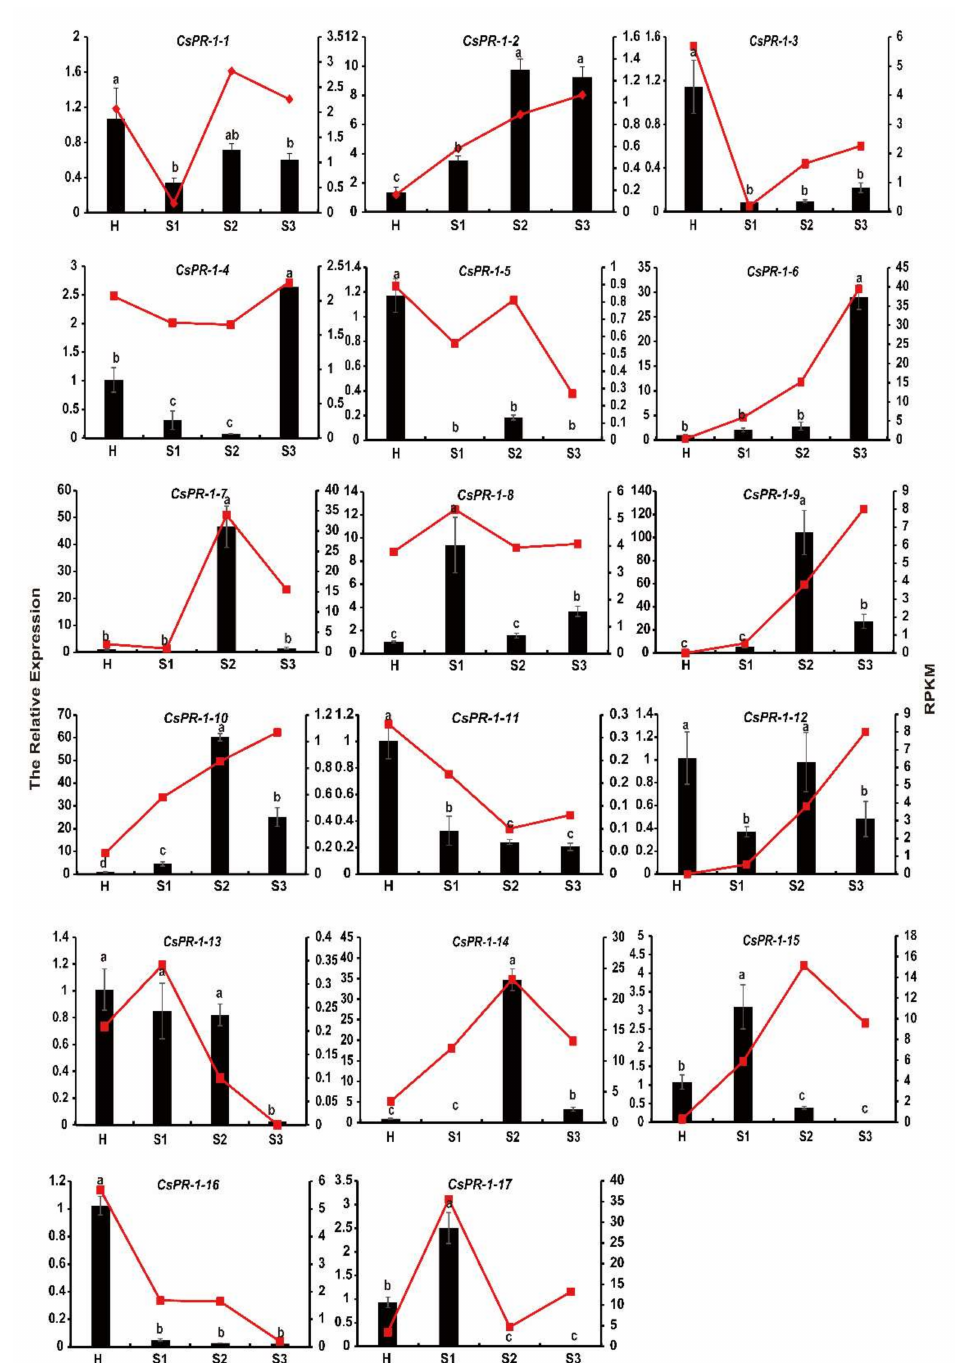
Figure 7. Comparison of the transcript expression results from the RNA-seq and qRT-PCR analysis of the CsPR-1 family genes under tea blister-blight disease stress. The relative expression of genes validated using qRT-PCR (bar chart, left ordinate) and the fragments per kilobase of transcript per million mapped reads obtained from transcriptome sequencing (line diagram, right